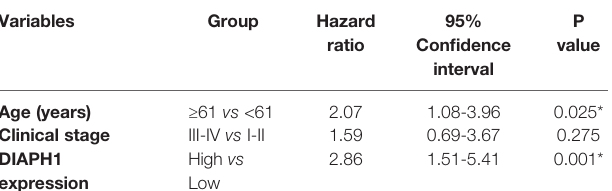
TABLE 4 | Multivariate cox proportional hazard regression for overall survival